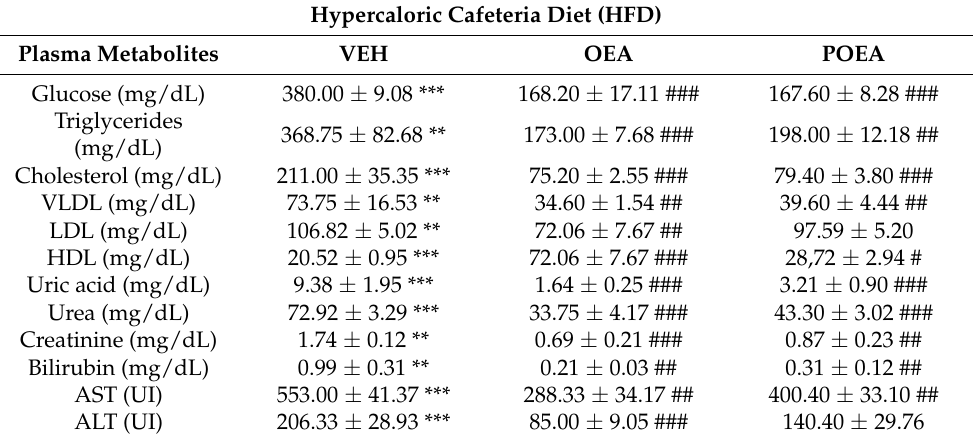
Table 3. Plasma biochemical parameters from animals fed HFD and treated with either OEA or POEA (10 mg/kg) for 15